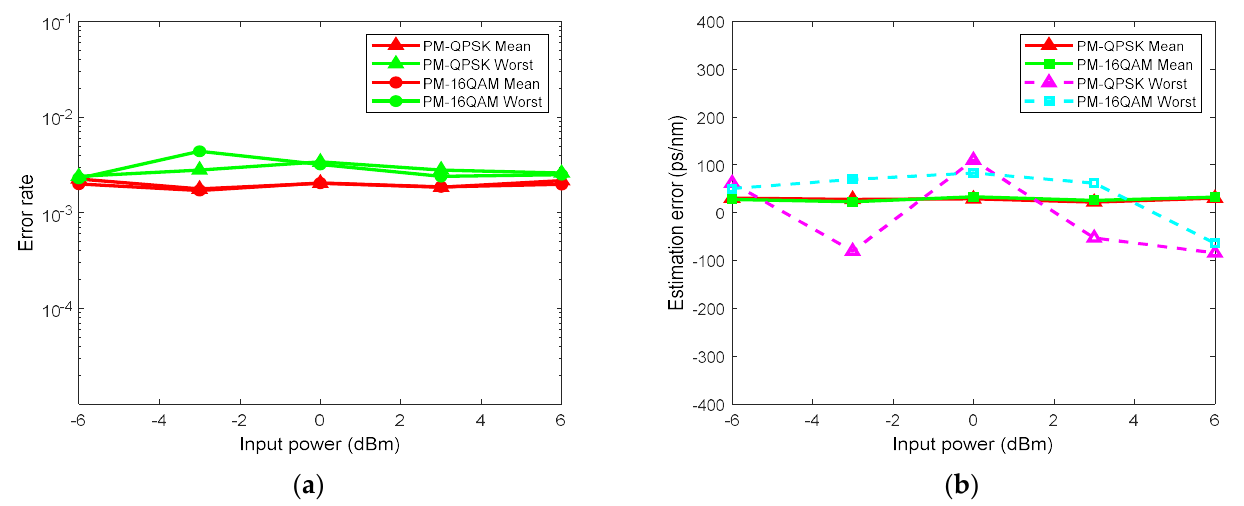
Figure 12. Relationship between ( a ) error rate and ( b ) estimation error with input power.